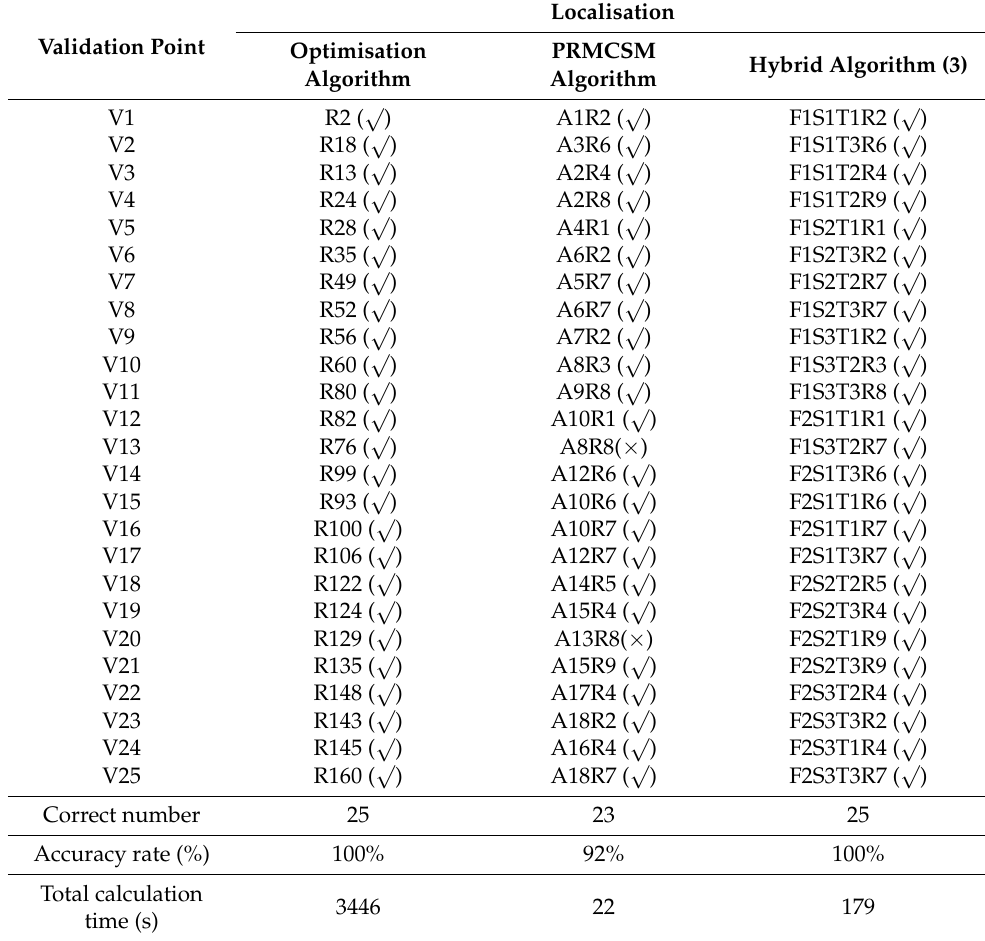
Table 4. Identification results of validation cases obtained with different